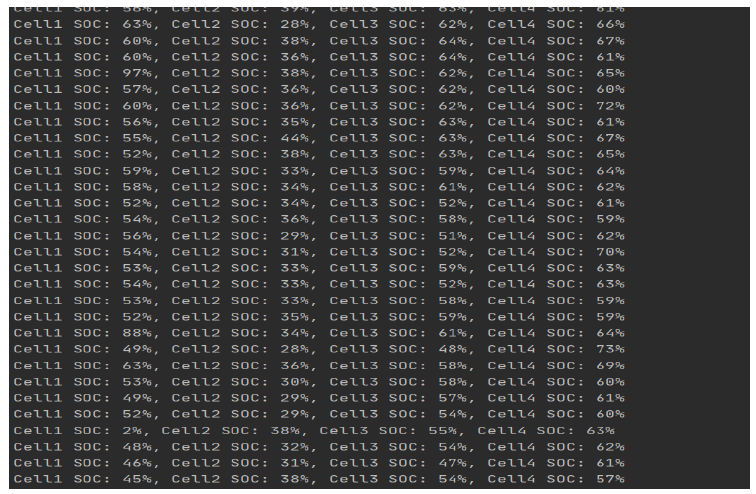
Figure 6. Real-time SOC estimation.